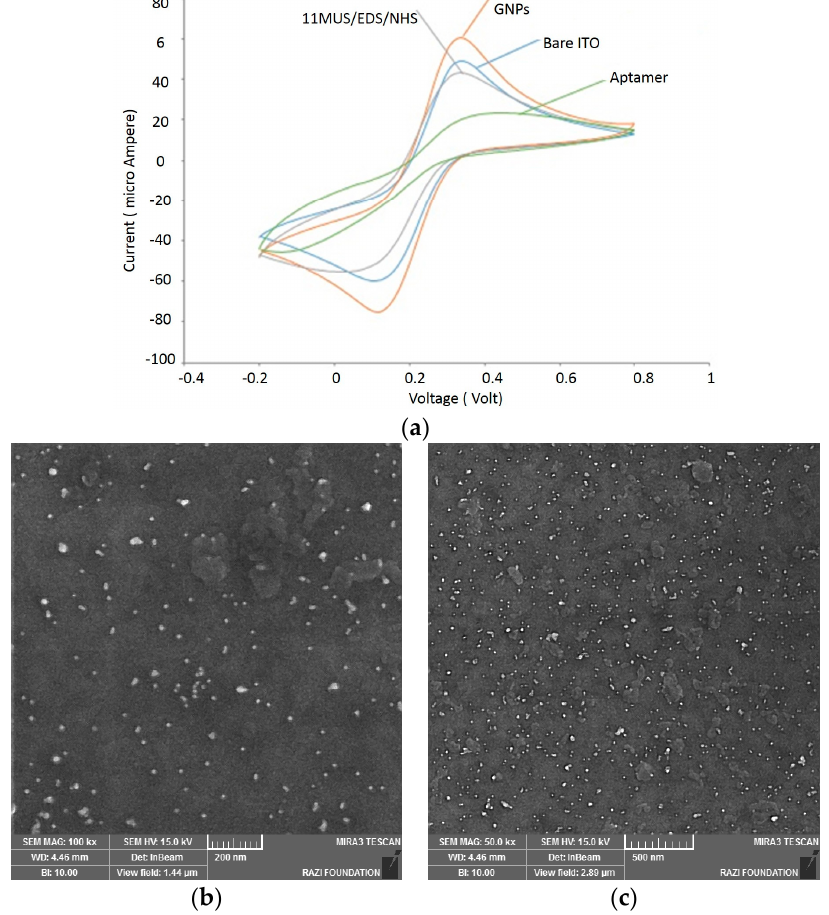
Figure 4. Characterization of apta-DSs ( a ) layer by layer CV characterization of apta-DS consisting of (bare ITO, deposition of GNPs on ITO, deposition of 11MUA/EDC/NHS on GNPs, and covalently bonding of aptamer on functionalized GNPs (11MUA/EDC/NHS/APT/BSA); FESEM microscopy in two different scales ( b ) 200 nm and ( c ) 500 nm scale bars. Electrode coated with 11MUA/EDC/NHS/Aptamer/BSA.